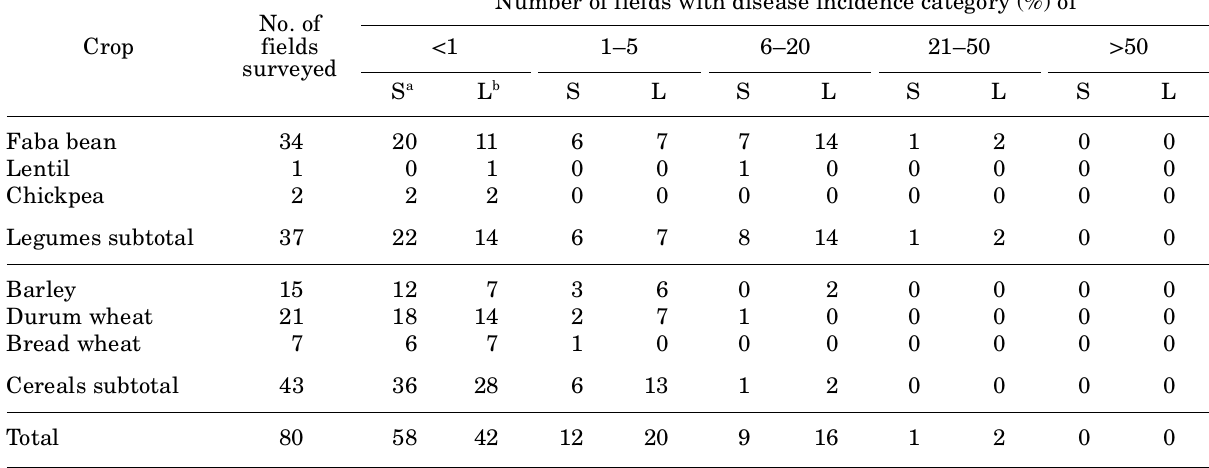
Table 1. Virus infection incidence in legume and cereal crops based on symptoms observed in the field and the laboratory testing of randomly collected samples. Survey conducted in Tunisia, April, 2000.